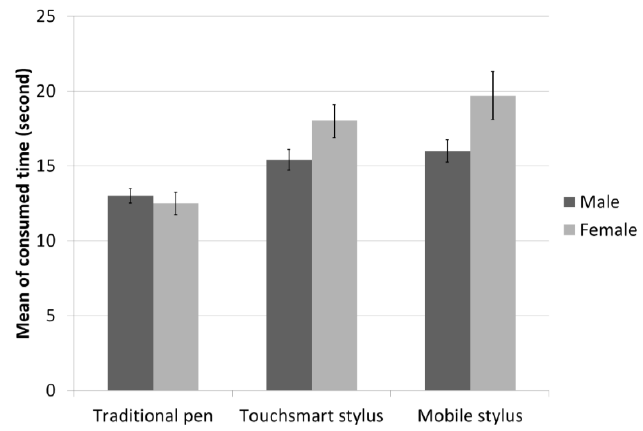
Figure 2. Mean of consumed time in first task (writing a